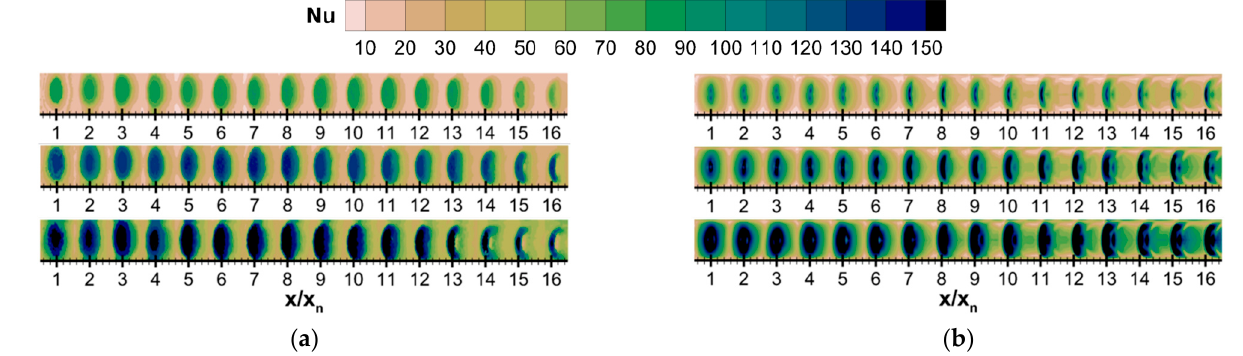
Figure 15. Local distributions of Nu for the variable extended configuration, from top to bottom: Re j = 1.0 × 10 4 , 2.0 × 10 4 and 3.0 × 10 4 ; ( a ) Exp; ( b ) CFD. The sub-plots from the top to the bottom correspond to the results from Re j values of 1.0 × 10 4 , 2.0 × 10 4 , and 3.0 × 10 4 , respectively. Nusselt number distributions from both